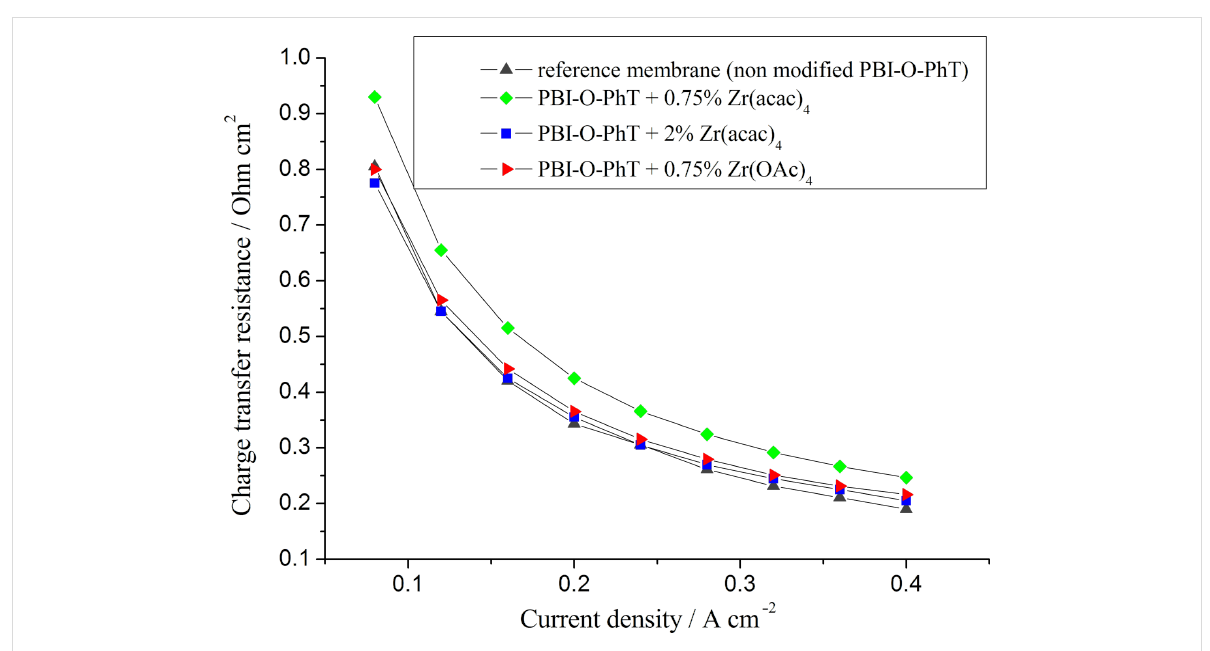
Figure 13: Polarization resistance (the sum of charge-transfer and mass-transfer resistances) as a function of the current density for fuel cells with different PBI membranes ( T = 160 °C). Higher resistances indicate a lower oxygen transport in the active layer because of a higher acid content in AL.